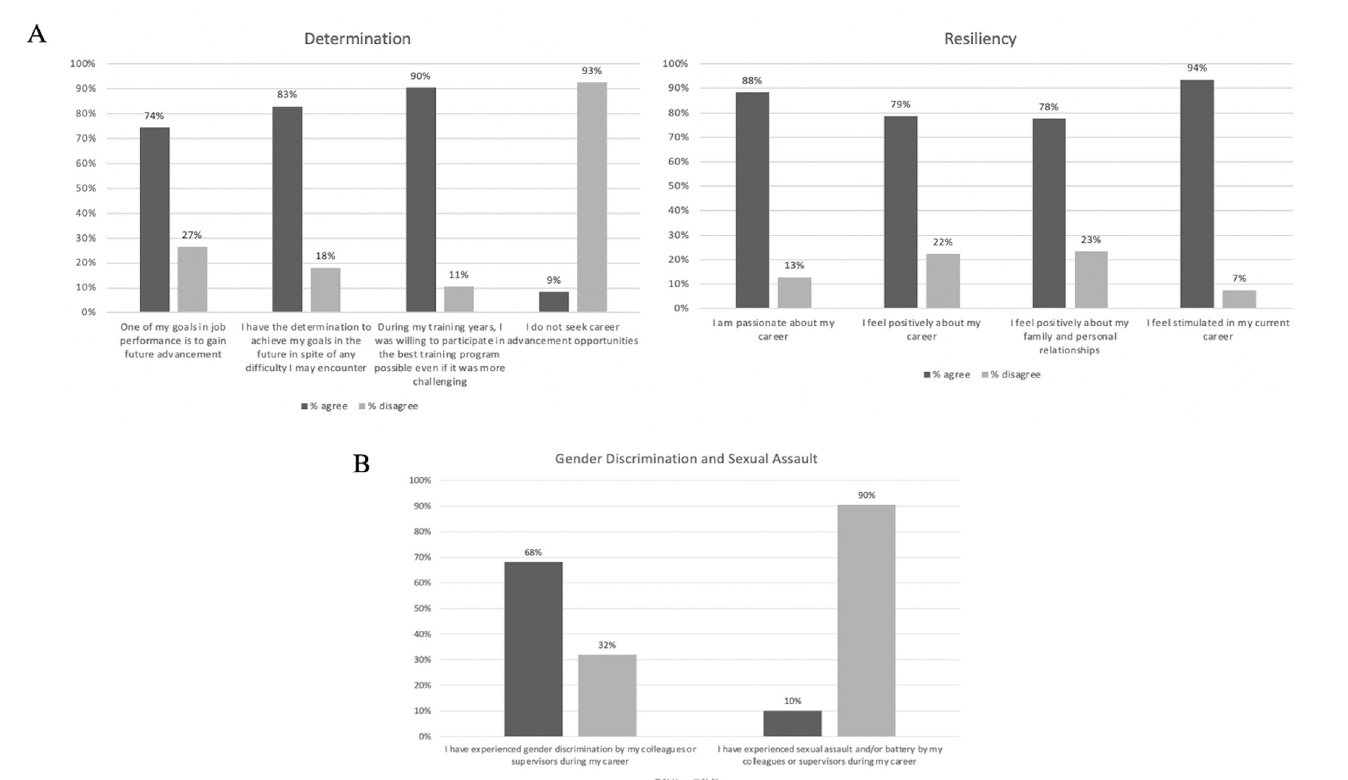
Figure. Combined findings of residents and faculty members 1A: Categorical groupings of residents and faculty members in determination and resiliency results; 1B: Those who experienced gender discrimination and sexual